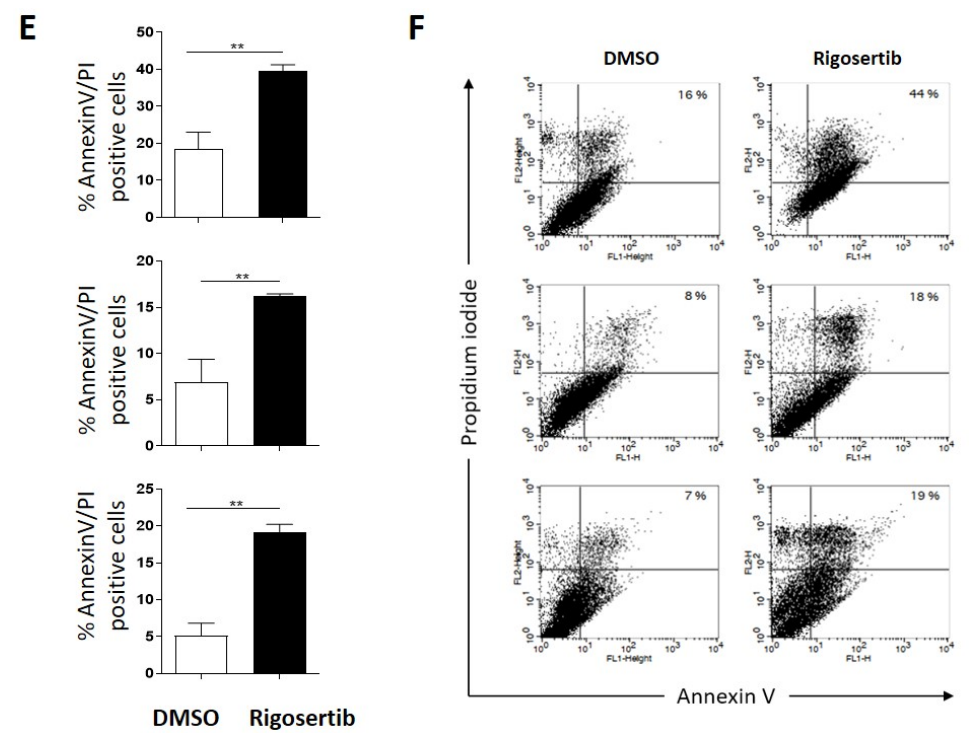
Figure 2. Rigosertib increases p66Shc activity and cell death in tumor cell lines. Representative Western blots show an increase in p66Shc activity ( A ), γ H2AX phosphorylation ( B ), and PARP cleavage ( C ) in MCF-7, PC3, and DU-145 cells stimulated with 50 µ M Rigosertib for 18 h. Numbers on top of the blot indicate the fold change in protein phosphorylation upon Rigosertib treatment (normalized to loading control) relative to DMSO (solvent)-treated control samples. For PARP, the ratio of cleaved and intact protein is shown. MCF-7, PC3, and DU-145 were imaged in phase contrast to detect cellular morphology ( D ) and analyzed for cell death by Annexin / PI after treating cells with either Rigosertib (50 µ M) or DMSO for 96 h. Results are presented as % of Annexin V-positive and PI-positive cells ( E ) and scattered plots ( F ). The drug-containing medium was refreshed after 48 h during 96 h incubation time. All experiments have been repeated at least three times with consistent results, except the Annexin / PI analysis for DU-145, which has been repeated twice. Values shown are mean ± S.D. A representative blot is shown. Scale bar size: 100 µm.